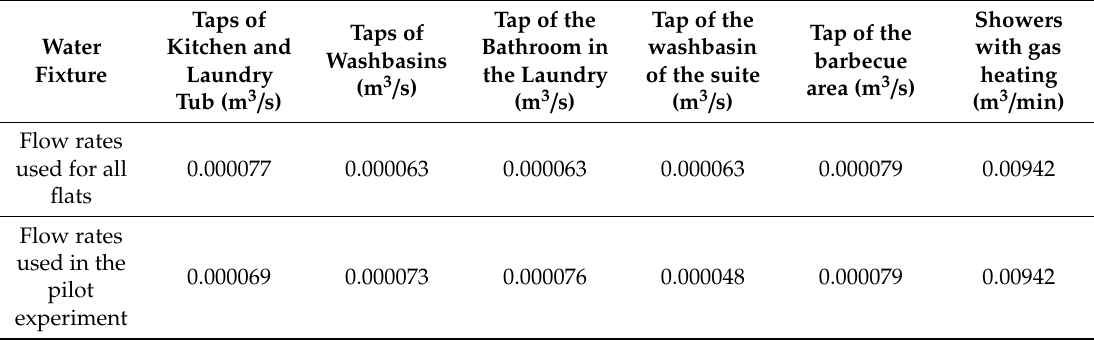
Table 5. Flow rates used to calculate the water consumption in the